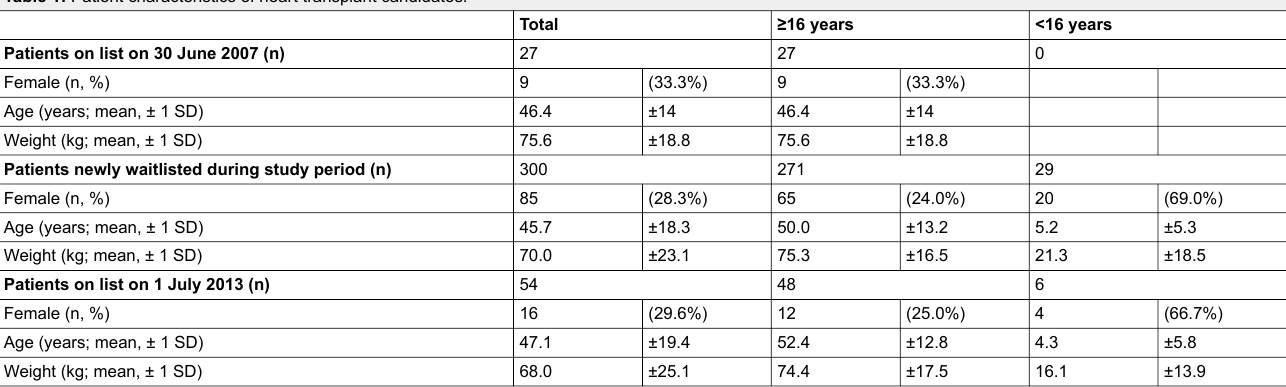
Table 1: Patient characteristics of heart transplant candidates.